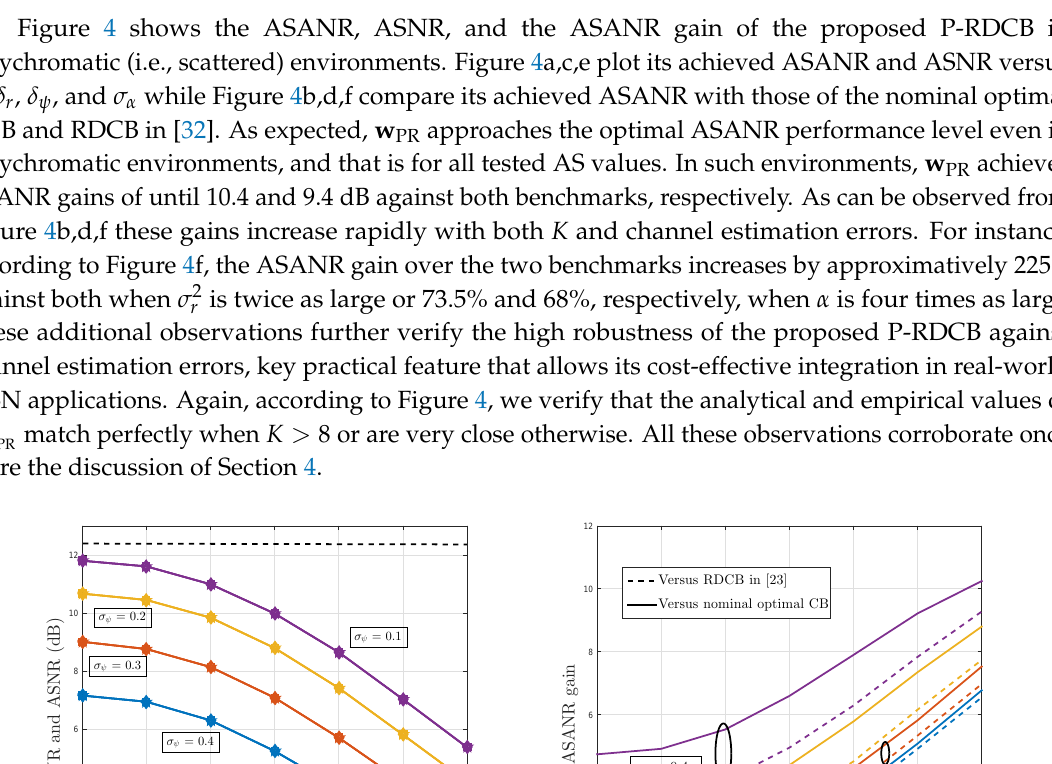
(b) ASANR gain vs. localization errors for different levels of DoA estimation errors and K = 16. Figure 3. ASANR gain of proposed M-RDCB in monochromatic environments under: ( a ) implementation Option 1, and ( b ) implementation Option